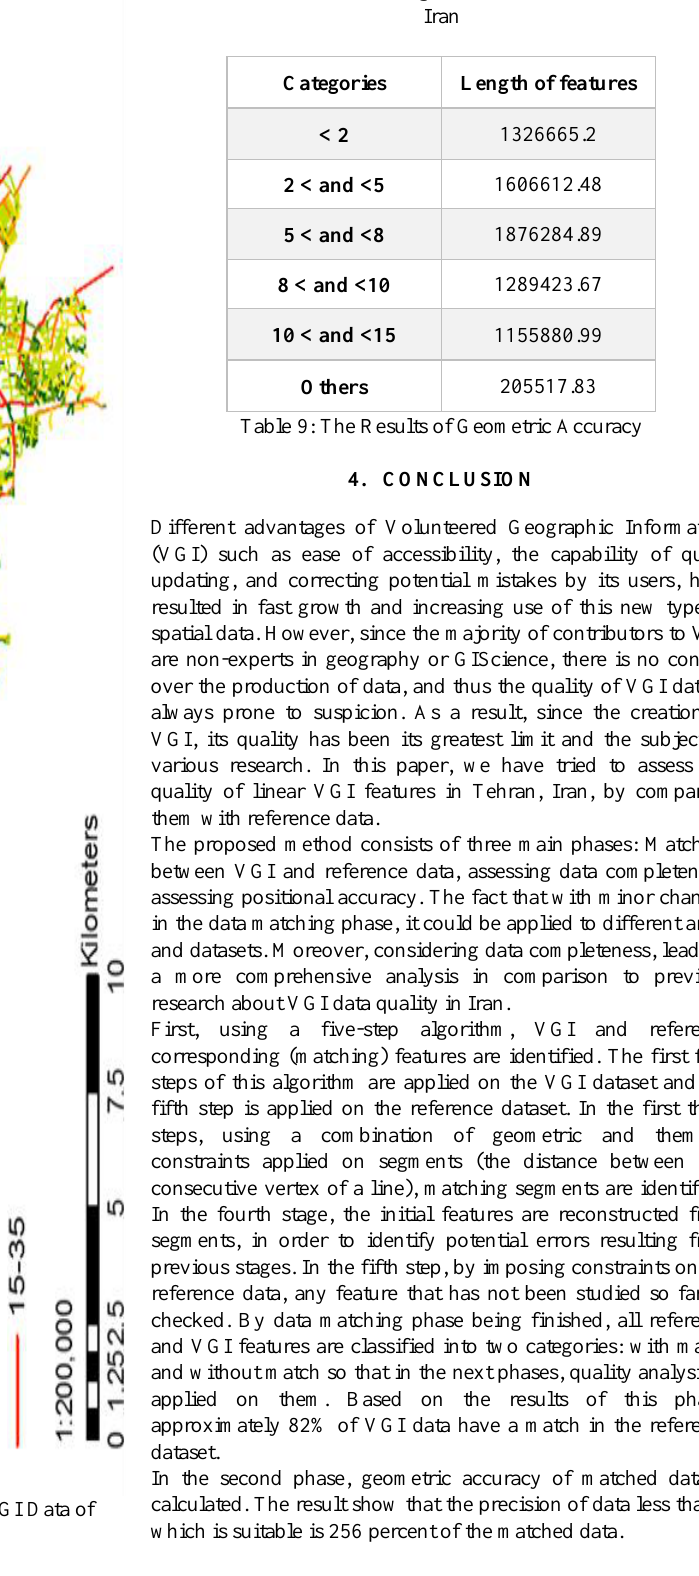
Table 8: The Results Matching of Matched VGI Data of Tehran,